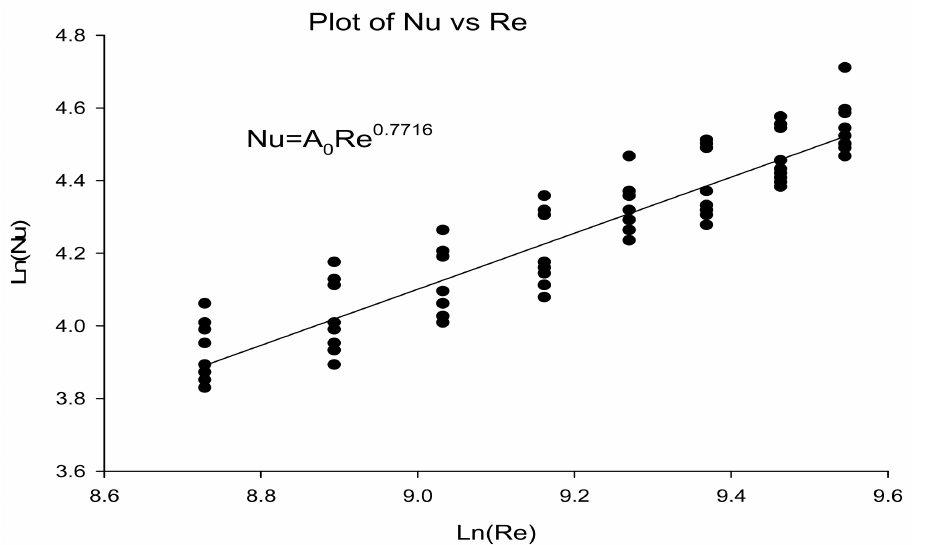
Figure 3. Experimental Variation of Nusselt number and Reynolds number.